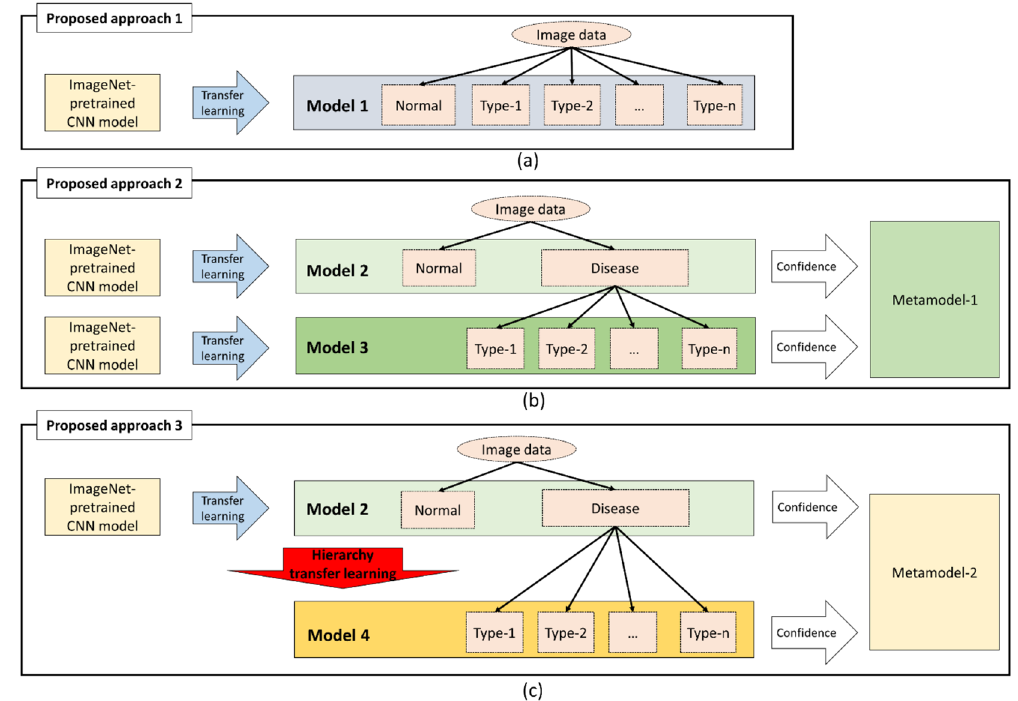
Figure 2. Proposed approaches for building deep learning models. Consider a classification problem (class number = n + 1) of normal and disease cases with n subtypes. (a) Proposed approach 1: flat classification is used to directly classify normal eyes and those with four subtypes of disease with transfer learning from an ImageNet- pretrained CNN model to create Model 1. (b) Proposed approach 2: hierarchical classification is used to create a low-level model (Model 2) for classifying normal versus disease cases and a high-level model (Model 3) for classifying subtypes of disease. Both models apply transfer learning from the ImageNet-pretrained CNN model. The confidence in a ‘normal’ result from Model 2 and the confidence in disease subtypes from Model 3 are concatenated to calculate the overall result from training Metamodel 1. (c) Proposed approach 3: hierarchical classification using hierarchy transfer learning between different-level models is used in the hierarchical classification model is. In contrast with proposed approach 2, the high-level model (Model 4) for classifying disease subtypes, transfer learning is from the low-level model (Model 2) instead of from the ImageNet- pretrained CNN model. The normal confidence from Model 2 and the disease subtype confidence from Model 4 are concatenated to train Metamodel 2 to calculate the overall